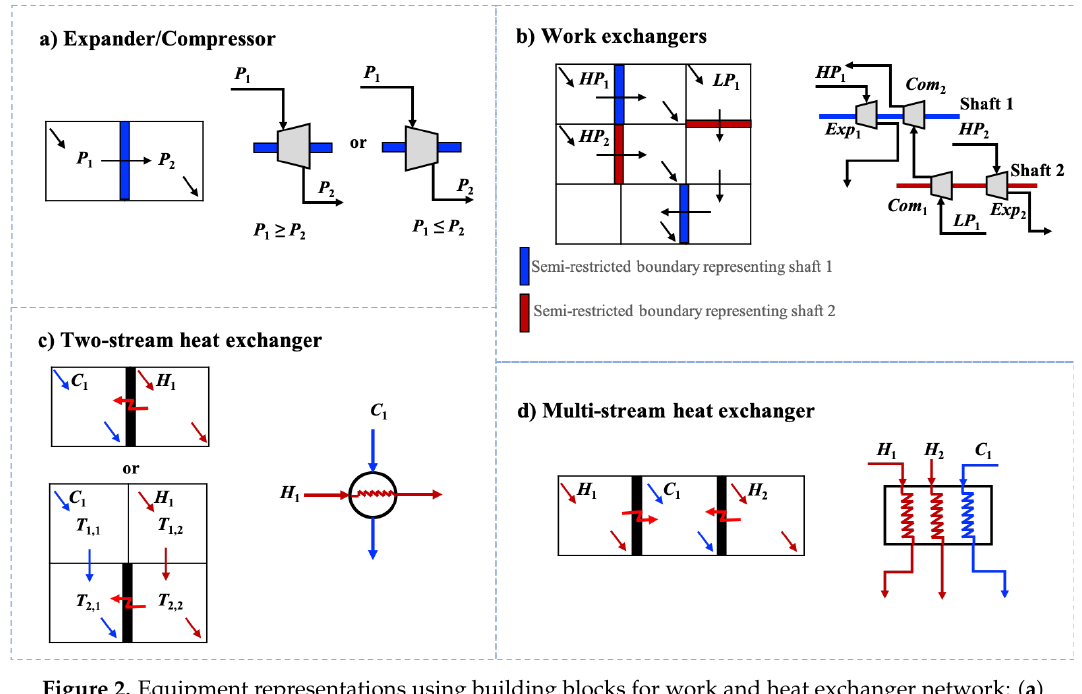
Figure 2. Equipment representations using building blocks for work and heat exchanger network: ( a ) Expander/compressor; ( b ) Work-exchanger shafts for work integration; ( c ) Two-stream exchanger for heat integration; ( d ) Multi-stream heat exchanger